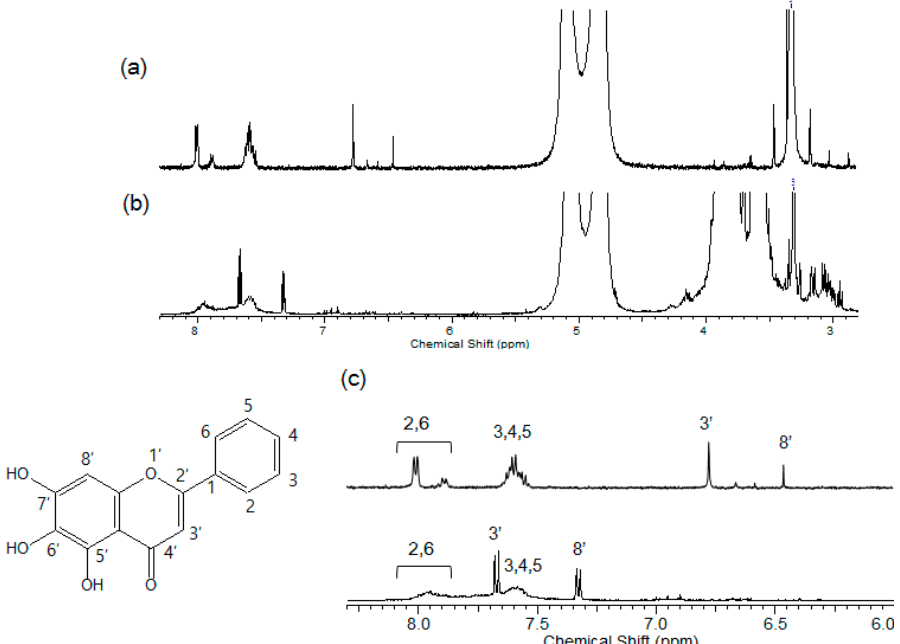
Figure 4. ( a ) 1 H-NMR spectrum of baicalein (Solvent: D 2 O:MeOD, 70:30, v / v ); ( b ) 1 H-NMR spectrum of cysteinyl β -CD/baicalein complex (Solvent: D 2 O:MeOD, 70:30, v / v ); ( c ) Enlarged spectrum of the aromatic region (top: baicalein, bottom: cysteinyl β -CD/baicalein complex). The inset shows the chemical structure of baicalein.